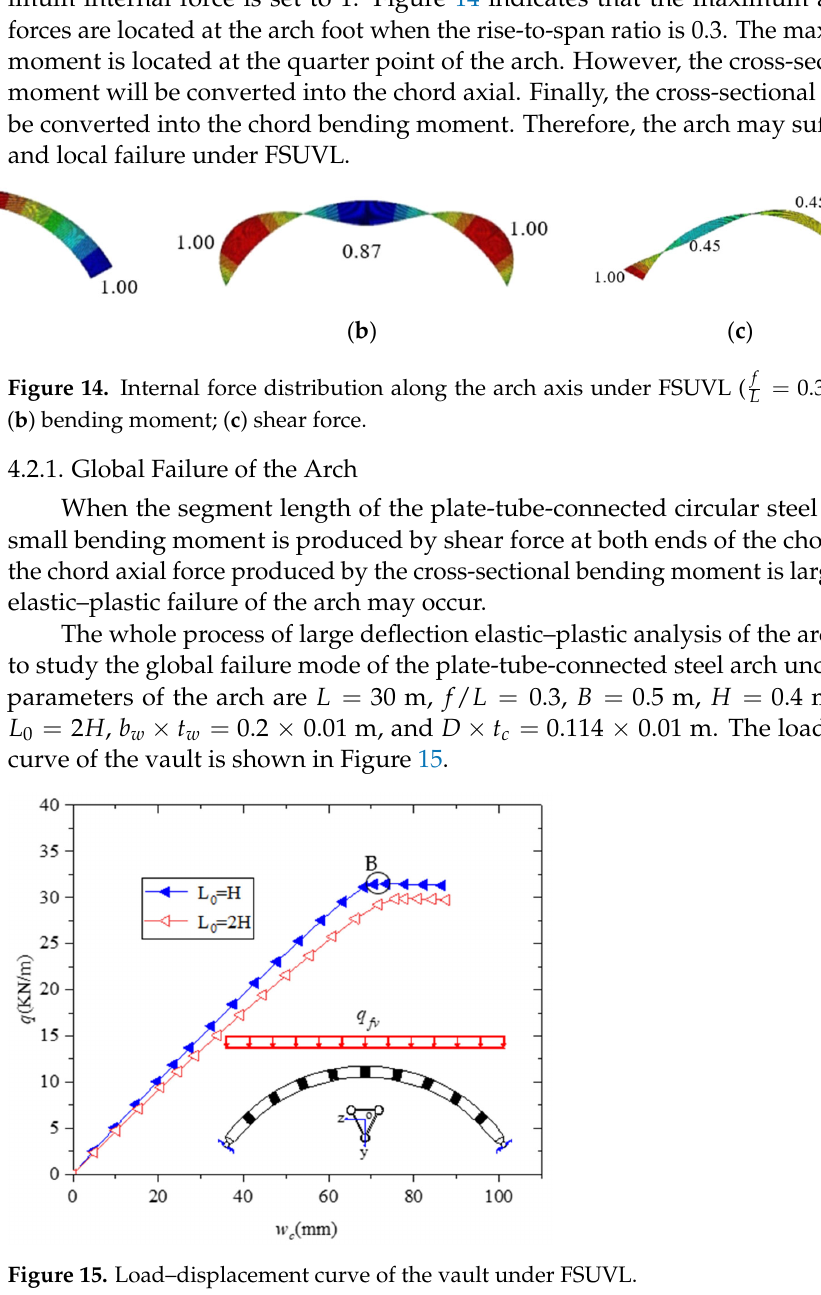
Figure 15. Load–displacement curve of the vault under FSUVL.